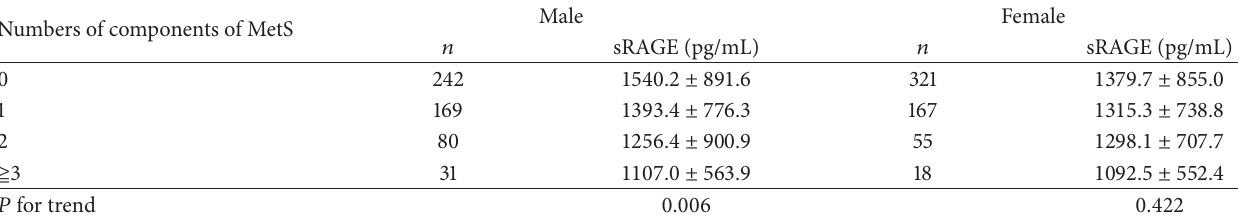
Table 5: Comparison of plasma sRAGE levels between numbers of components of MetS by